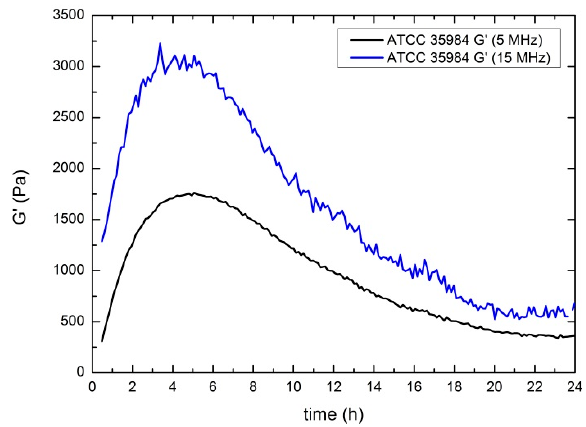
Figure 7. Evolution of the real shear modulus for 5 MHz (black) and 15 MHz (blue). Results obtained for S. epidermidis ATCC 35984 (biofilm producing) strain.